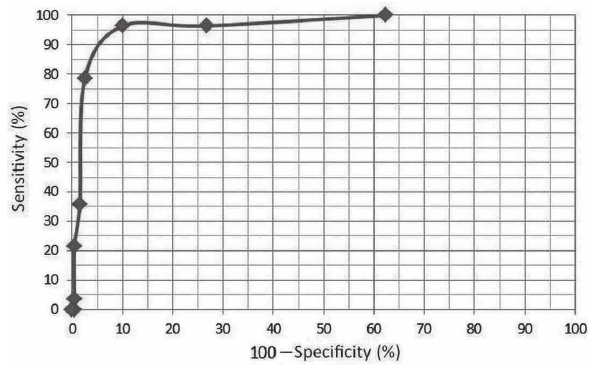
Fig. 1 – Receiver operating characteristic (ROC) curve - Area under the curve 96.2% (95.0% Confidence Interval 94.5%-97.9%). The curve is based on cut-off 2 (two) by